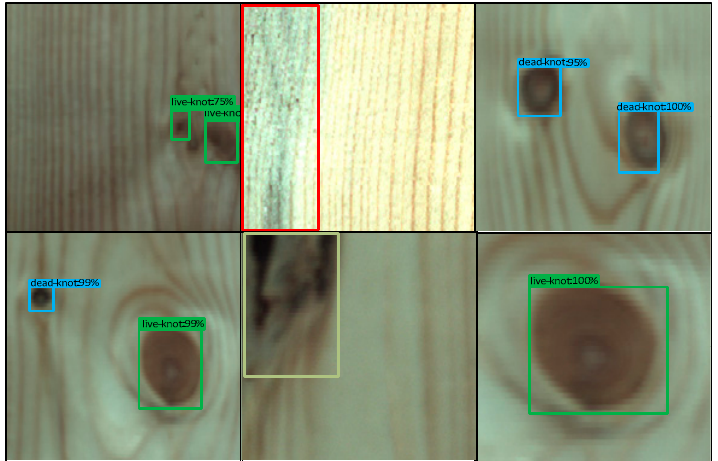
Figure 9. Recognition results based on deep learning.